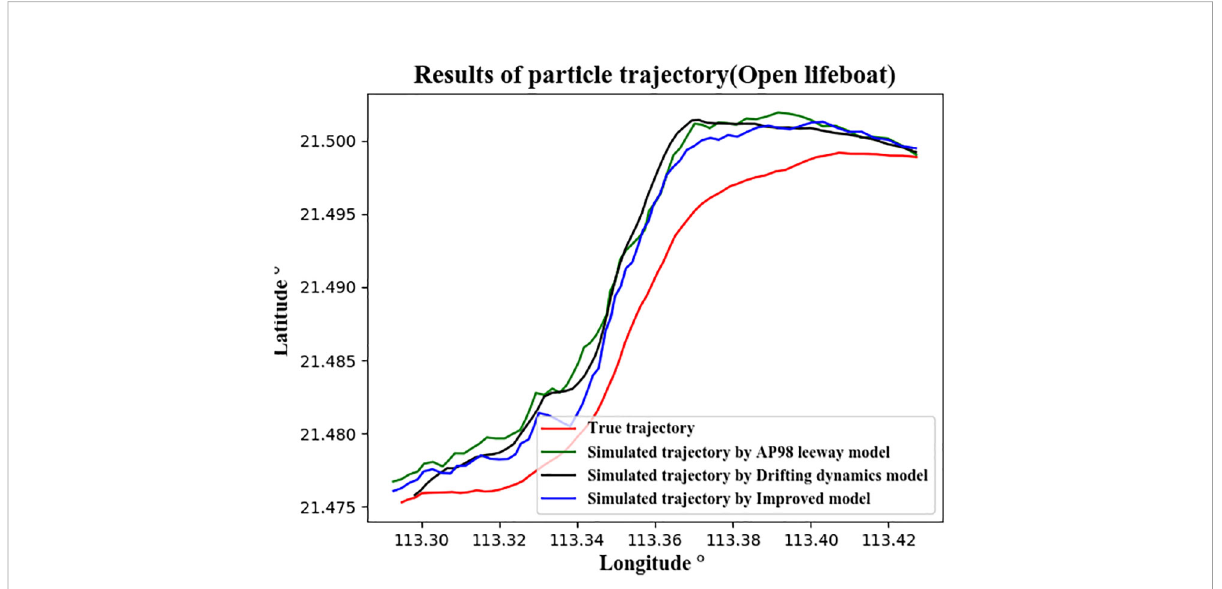
FIGURE 11 The true trajectory and the simulated trajectories using the Lagrangian particle tracking method for the open lifeboat in Case 1. The red line represents the true trajectory, and the green, black and blue lines represent the trajectories simulated by the leeway drift model, the dynamic drift model and the improved drift model,